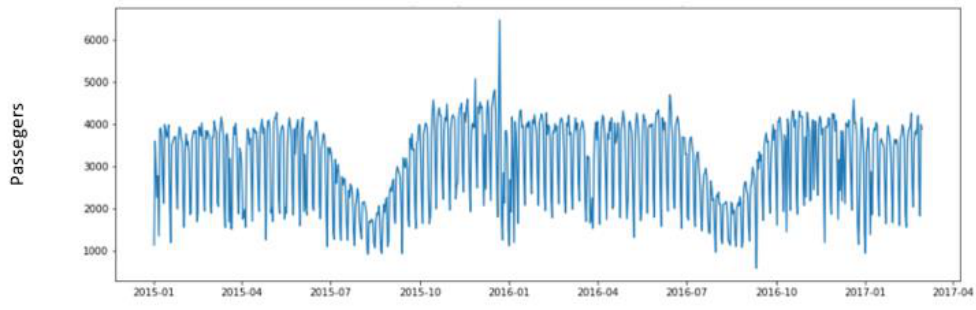
Figure 5. Daily number of passengers in the afternoon.